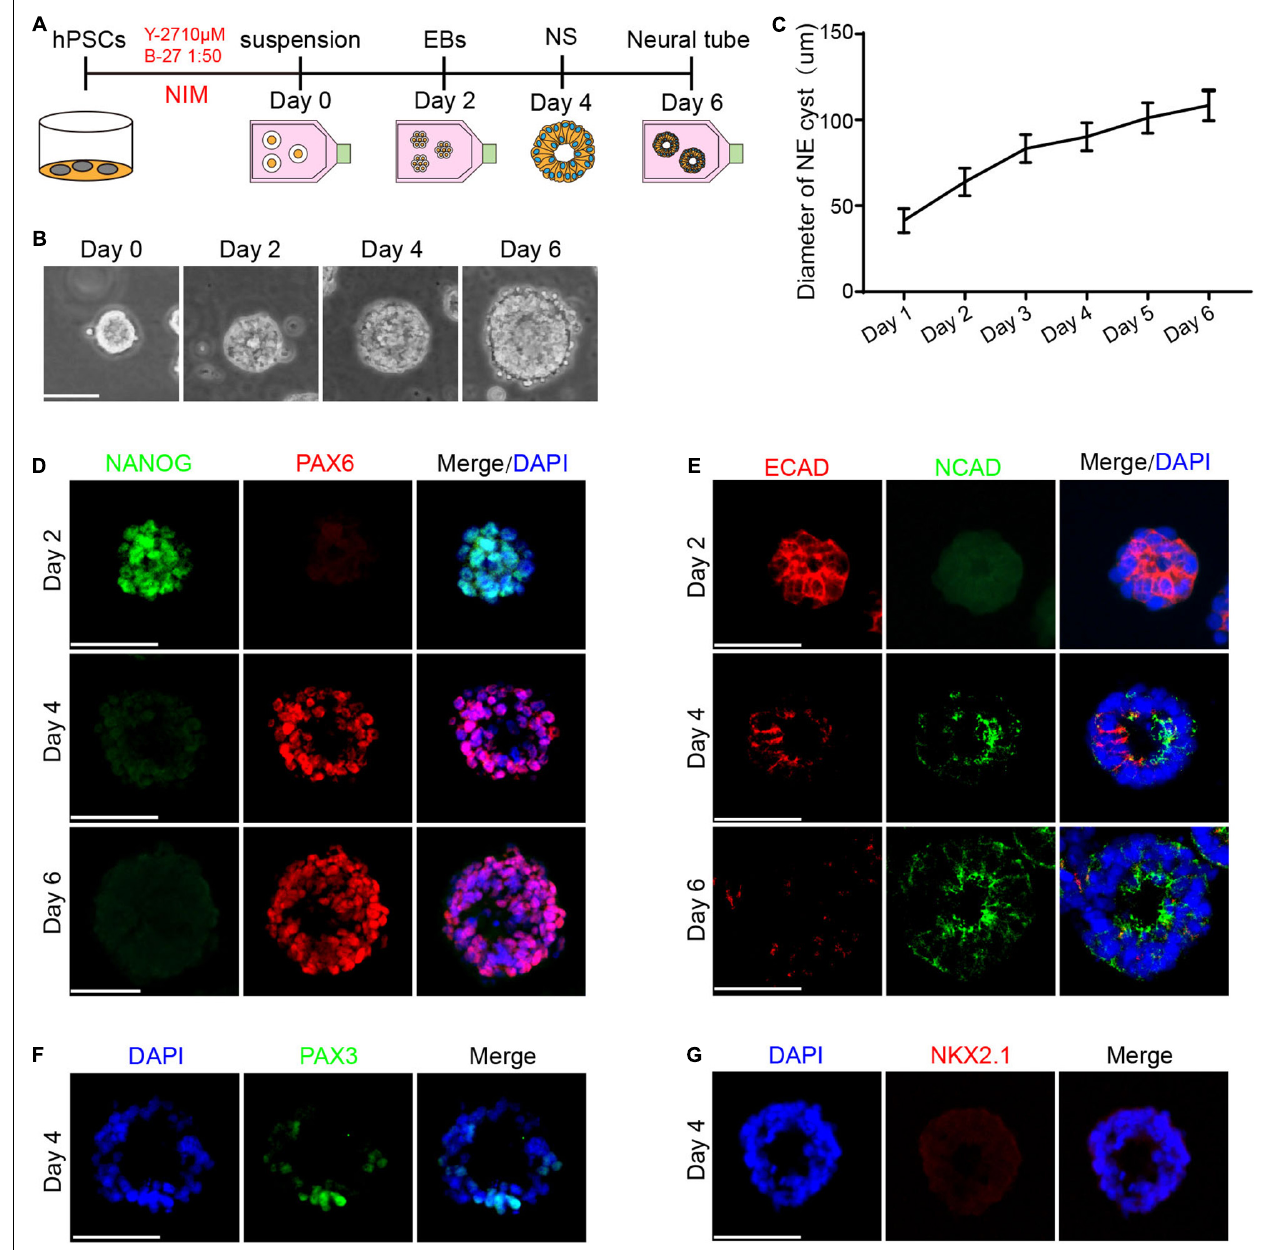
FIGURE 1 | Cell fate specialization of the neural rosette. (A) A schematic diagram illustrating the method of differentiating hPSCs to the neural rosette (Meinhardt et al., 2014). (B) Morphological results showed that the neural rosette contains a central cavity. (C) The diameter of cell aggregates from day 1 to day 6, n = 25. (D) The expression of NANOG decreased and the expression of PAX6 increased during differentiation. (E) There was a transition of the temporal-spatial expression pattern of ECAD and NCAD during the differentiation. (F) The expression of PAX3 at day 4. (G) The expression of NKX2.1 at day 4. Scale bars: 50 µ